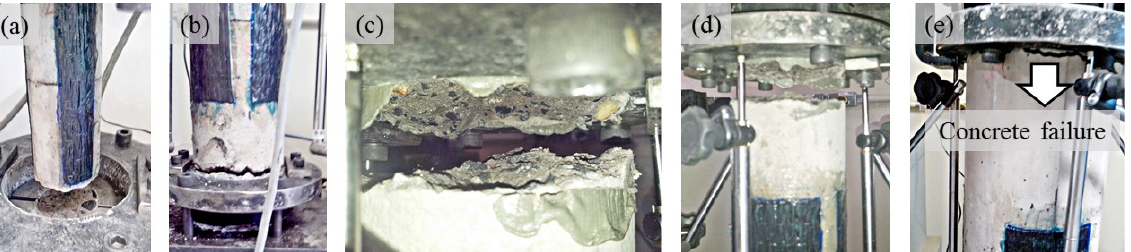
Figure 8. Experiments with concrete failure: a) FRP geometry G02 and 50 mm × 100 mm specimens; b) FRP geometry G05 and 100 mm × 200 mm specimens; c) FRP geometry G08 and 100 mm × 200 mm specimens; d) FRP geometry G10 and 100 mm × 200 mm specimens; e) FRP geometry G10 and 150 mm × 300 mm